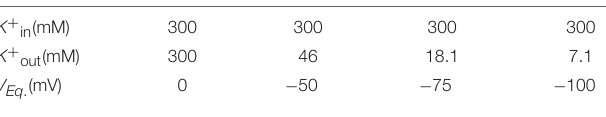
TABLE 2 | Calculated K + equilibrium potentials used in calibration of DiSC 3 (5)